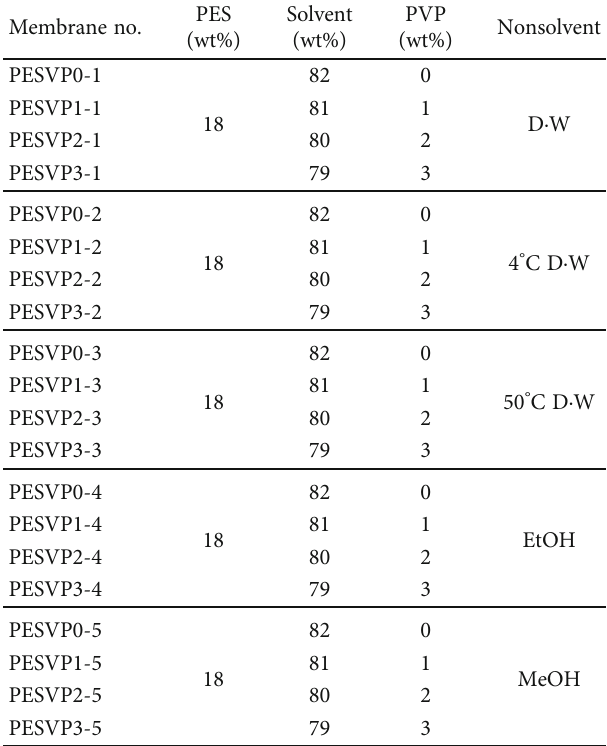
Table 1: Composition of polymer